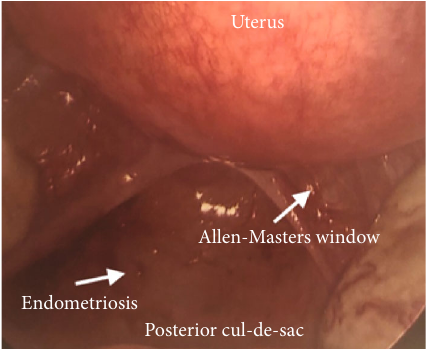
Figure 4: Laparoscopic image of posterior cul-de-sac, including endometriosis and Allen-Masters window.